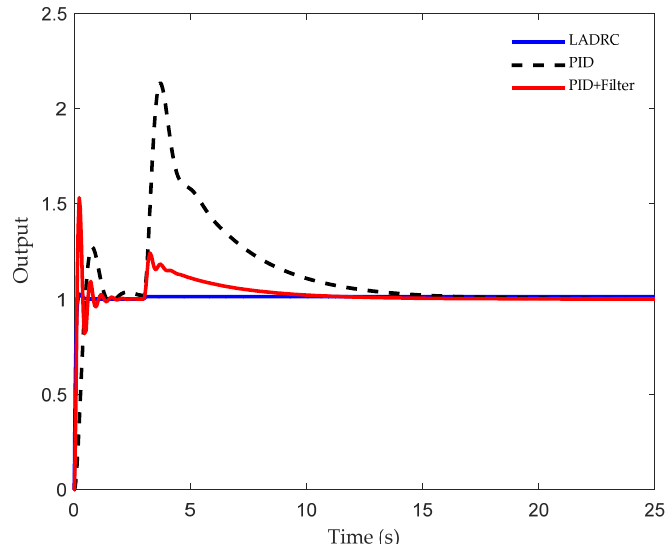
Figure 9. Step response simulation results with constant disturbance (under three controllers).